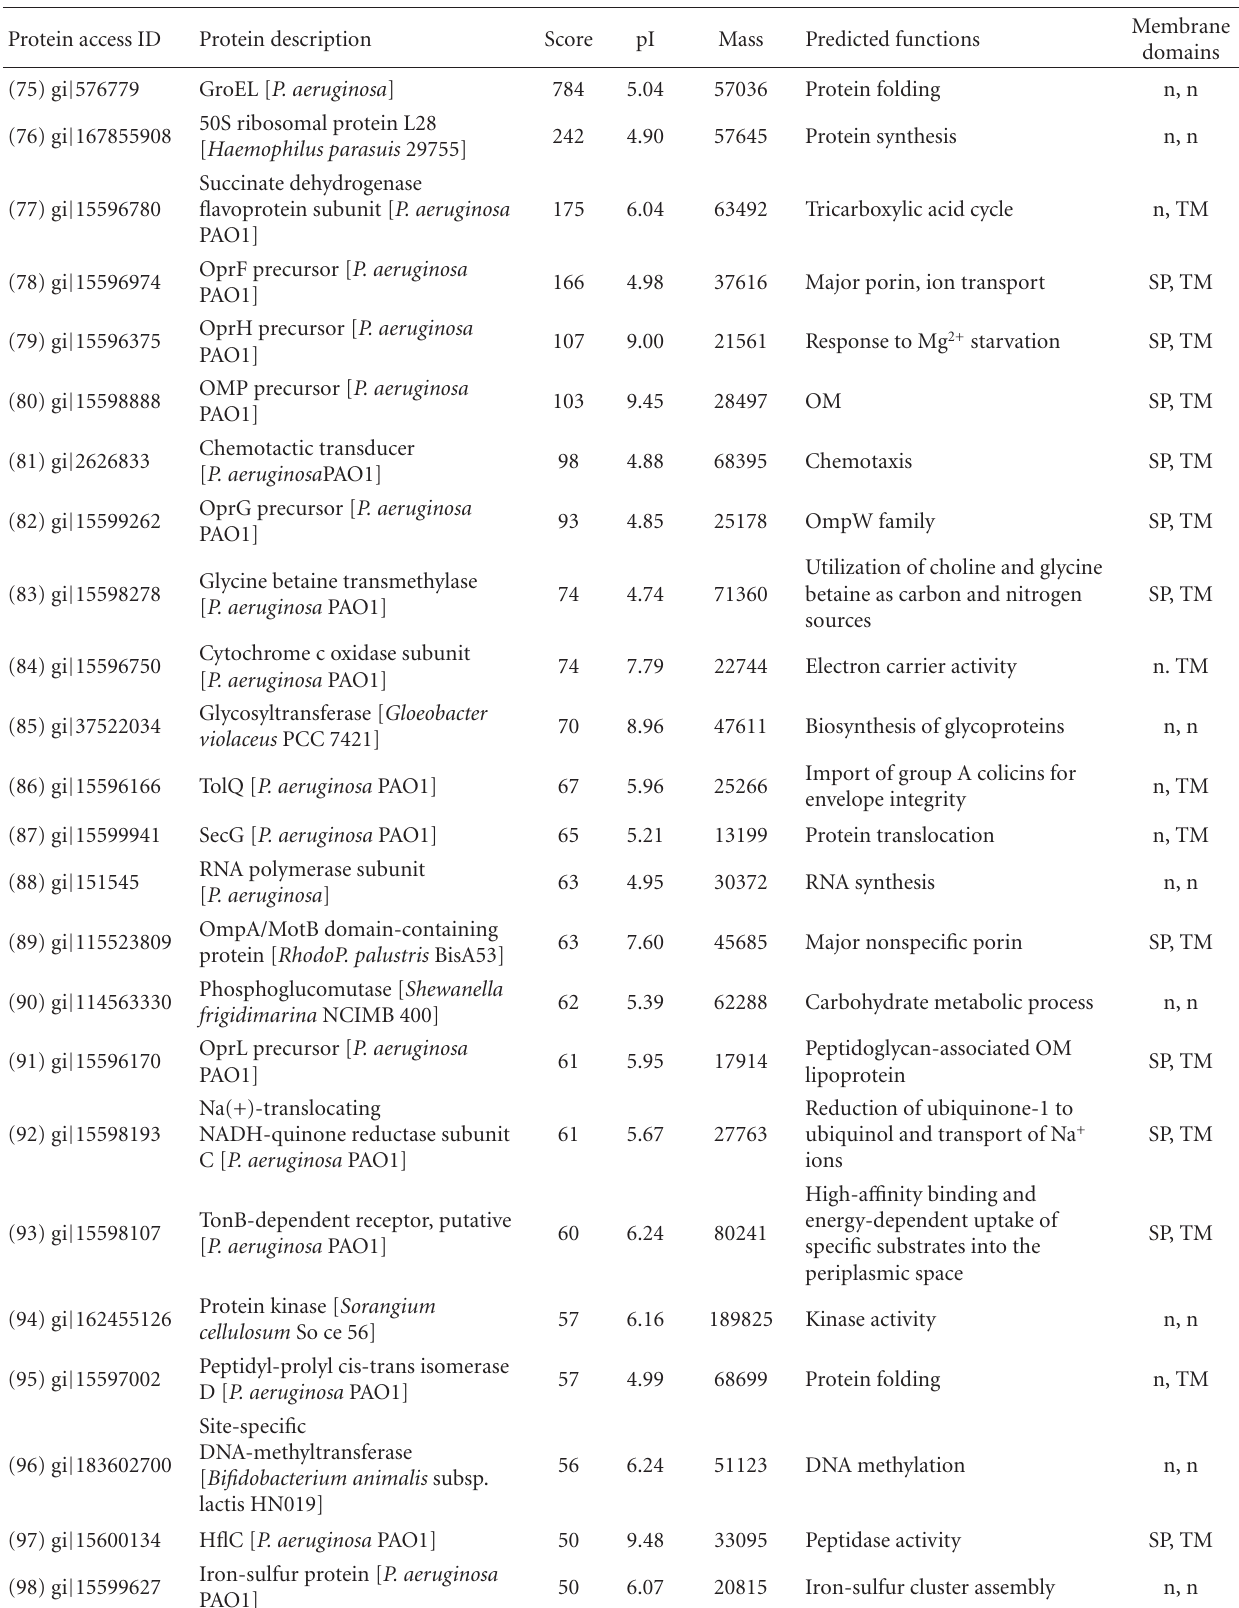
Table 2: The common OMV